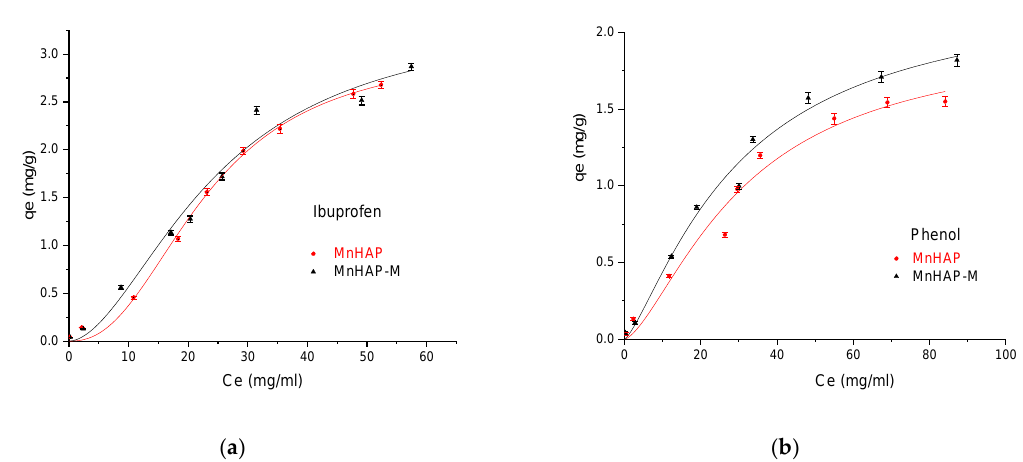
Figure 8. Influence of the adsorbent type in the adsorption process using ibuprofen as pollutant ( a ), and phenol ( b ), respectively.